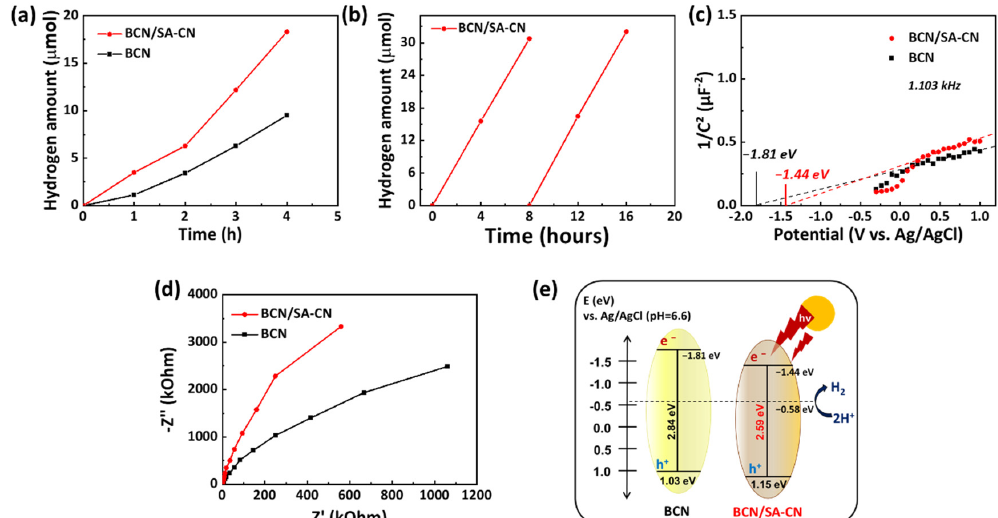
Figure 7. ( a ) Photocatalytically evolved hydrogen amount with BCN and BCN/SA-CN in 4 h of photoreaction, ( b ) cycle stability performance of BCN/SA-CN, ( c ) Mott-Schottky plot of BCN and BCN/SA-CN at frequency 1.103 kHz, ( d ) electrochemical impedance spectroscopy (EIS) of BCN and BCN/SA-CN at 0.5 V vs. Ag/AgCl (3 M KCl), and ( e ) schematic description of band structure for BCN and BCN/SA-CN. Table 3. The performance comparison of photocatalytic hydrogen evolution among g-CN samples.